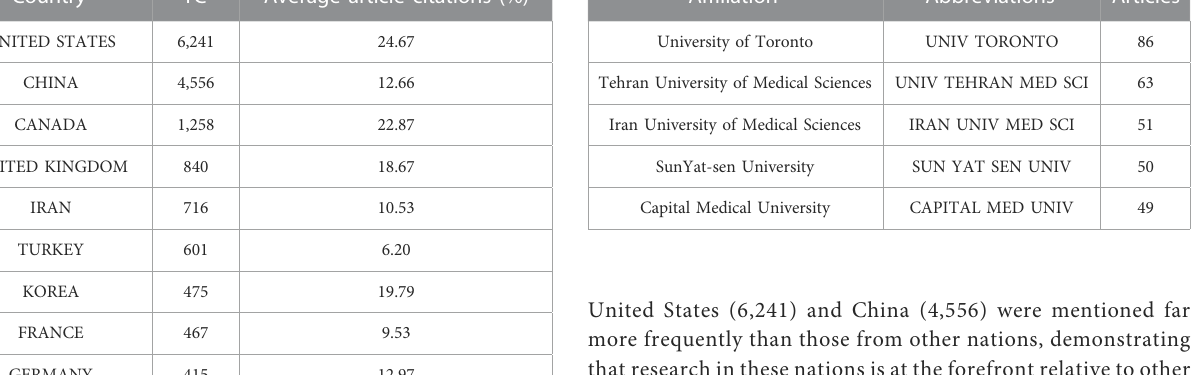
TABLE 2 Top fi ve af fi liation abbreviations and number of published articles. Af fi